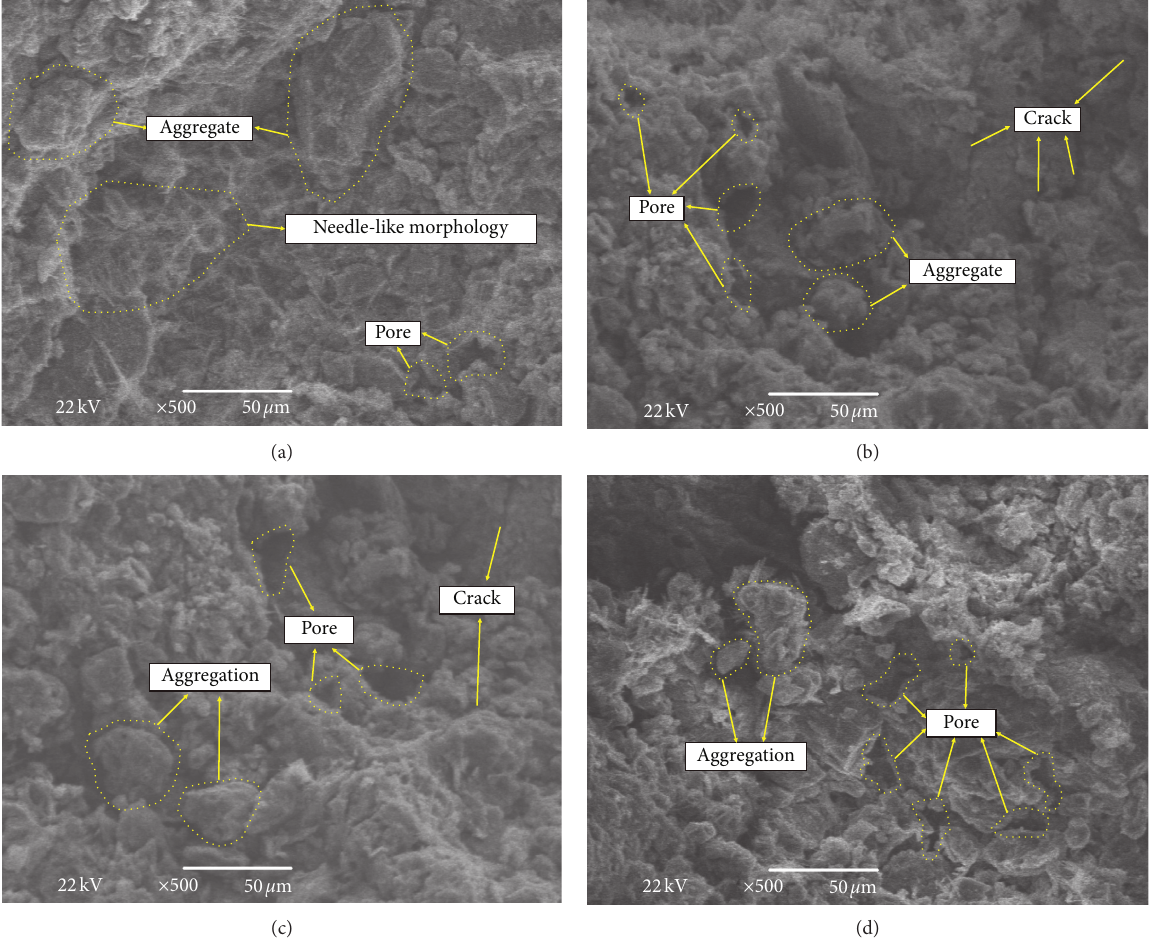
Figure 7: Microstructural feature encountering drying-wetting cycles. (a) 1st cycle, (b) 5th cycle, (c) 7th cycle, and (d) 10th cycle.